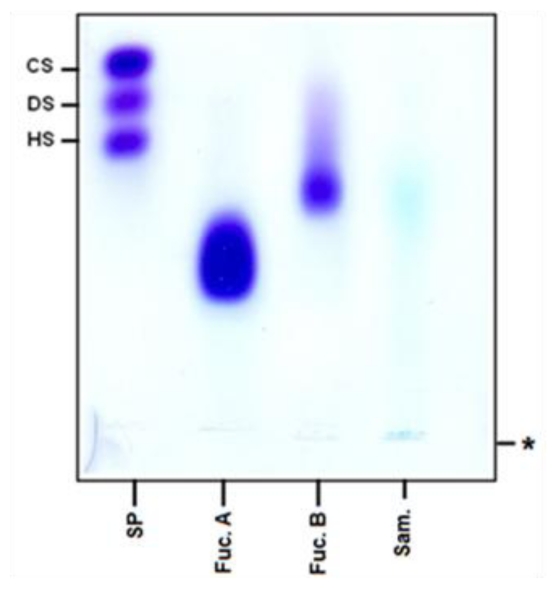
Electrophoretic pattern of xylan from corn cobs. Aliquots of 50 μg of fucan A and B and 5 μg of sulfated glycosaminoglycans, and 100 μg of xylan were applied in agarose gel, PDA buffer 0.05 M, pH 9.0. After precipitation with CETAVLON slides were stained with toluidine blue. SP: Sulfated polysaccharides; CS: chondroitin sulfate; DS: dermatan sulfate; HS: Heparan sulfate; Fuc. A: Fucan A from brown seaweed Spatoglossum schroederi; Fuc. B: Fucan B from Spatoglossum schroederi; Sam: Sample (xylan); * origin.